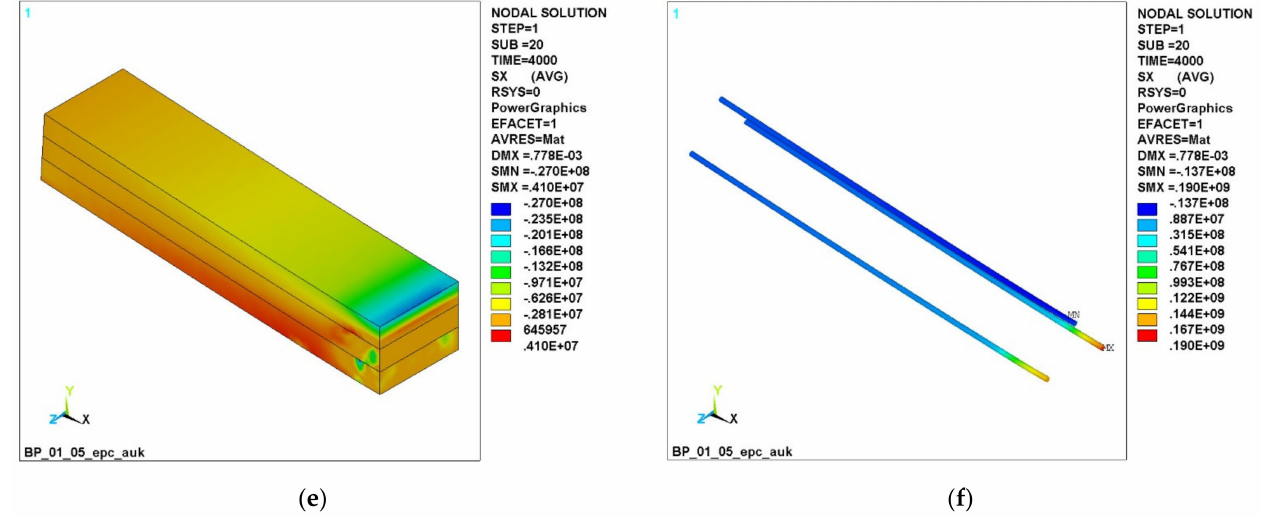
Figure 7. Fields of normal stresses σ X at a load of 4000 N: ( a ) in concrete with GCR; ( b ) in GCR; ( c ) in concrete with BCR; ( d ) in BCR; ( e ) in concrete with CCR; ( f ) in CCR.